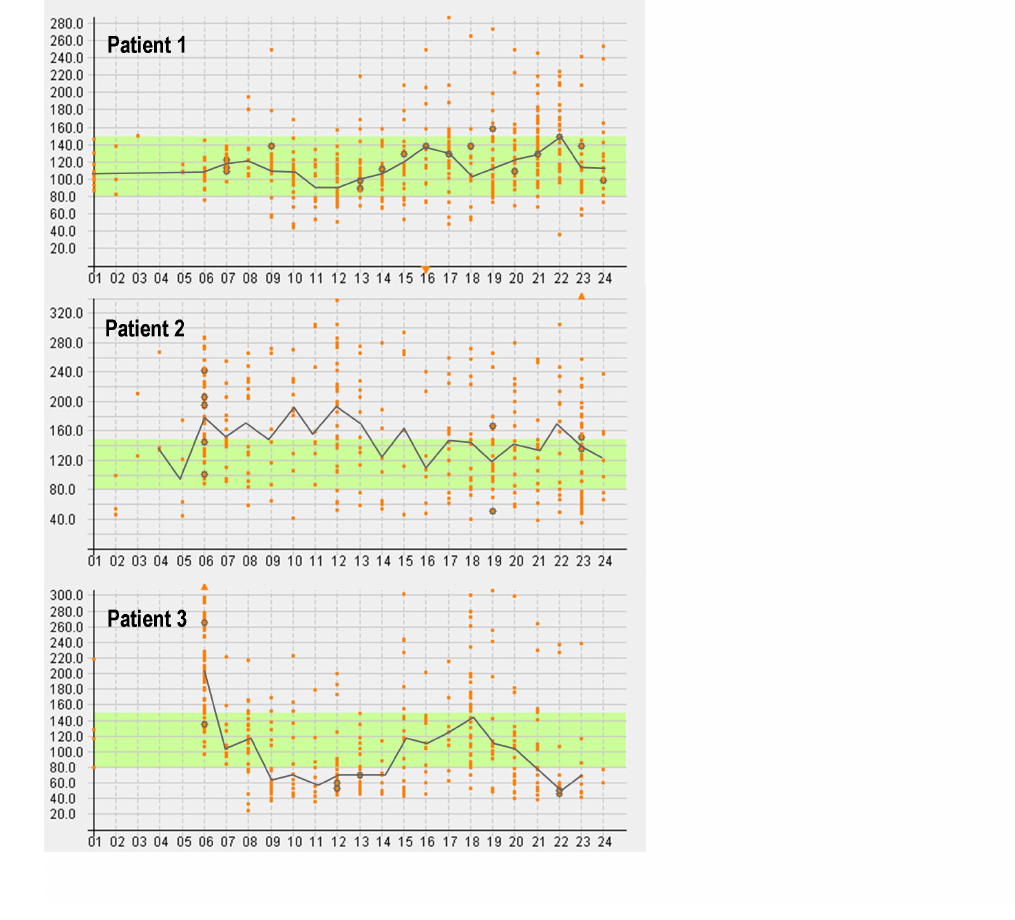
P ValueAfter the StudyBefore the Study